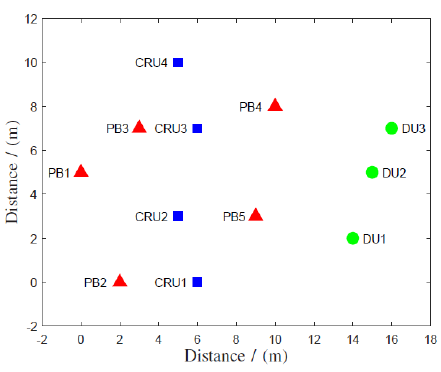
Figure 2. System coordinates.